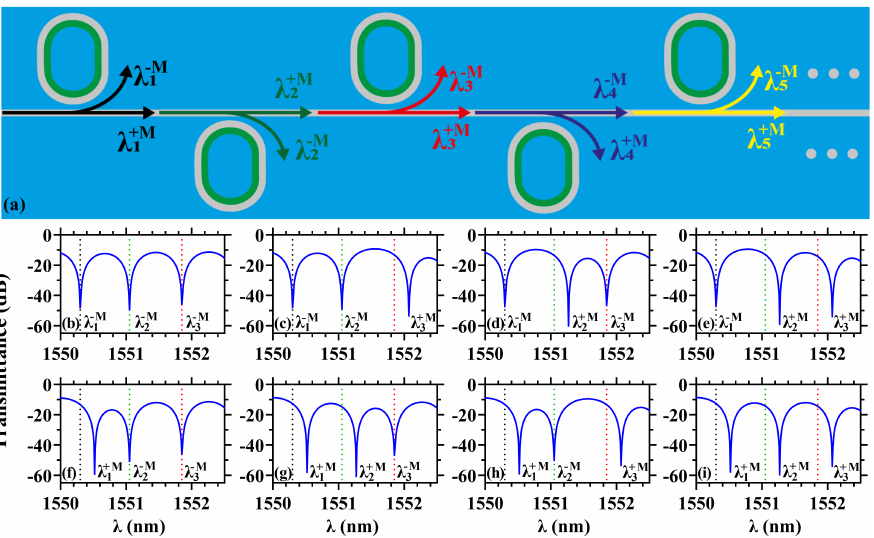
Figure 5. ( a ) Schematic representation of multiple MO-MRRs side-coupled to a single Si-waveguide for massive MO modulation in DWDM applications. ( b – i ) MO modulation in DWDM for different ) . , λ ± M , λ ± M combinations of ( λ ± M 2 3 1